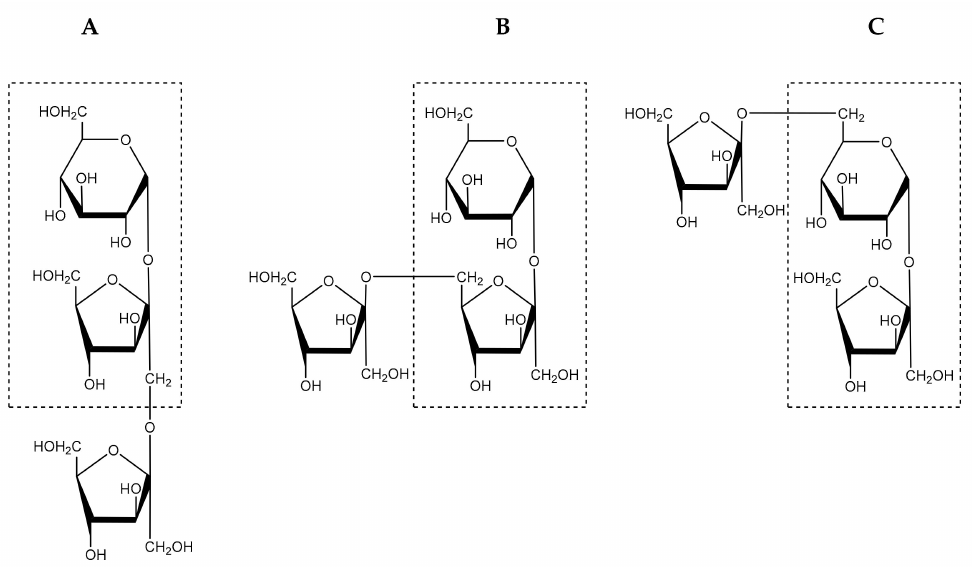
Figure 4. Structure of trisaccharides building fructan structure: ( A ), 1-kestotriose; ( B ), 6-kestotriose; and ( C ), 6G-kestotriose. The sucrose core is shown in the rectangle box. Based on Verspreet et al.